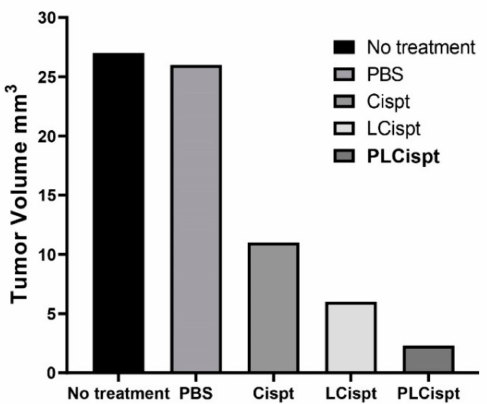
Figure 7. The tumor volume (mm 3 ) in bladder cancer (BC)-bearing rats that received di ff erent formulations, including phosphate-bu ff ered saline (PBS), Cispt, LCispt, and